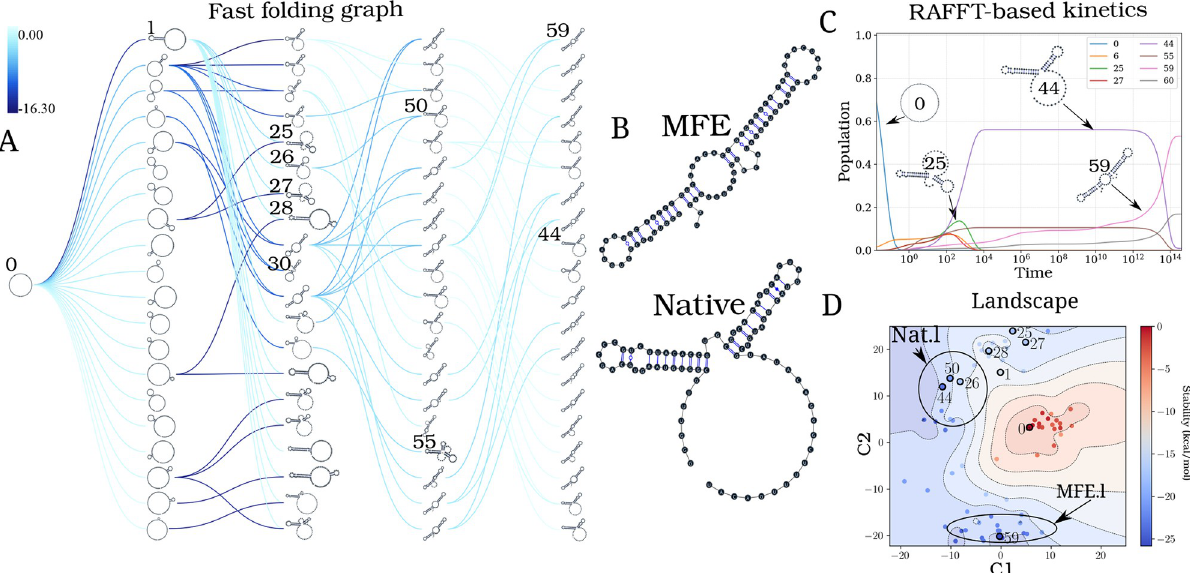
Fig 7. Application of the folding kinetic ansatz on CFSE. (A) Fast-folding graph in four steps and N = 20 structures stored in a stack at each step. The edges are coloured according to ΔΔ G . At each step, the structures are ordered by their free energy from top to bottom. The minimum free energy structure found is at the top left of the graph. A unique ID annotates visited structures in the kinetics. For example, “59” is the ID of the MFE structure. (B) MFE (computed with RNAfold ) and the native CFSE structure. (C)The change in structure frequencies over time. The simulation starts with the whole population in the open-chain or unfolded structure (ID 0). The native structure ( Nat.l ) is trapped for a long time before the MFE structure ( MFE.l ) takes over the population. (D) Folding landscape derived from the 68 distinct structures predicted using RAFFT . The axes are the components optimized by the MDS algorithm, so the base pair distances are mostly preserved. Observed structures are also annotated using the unique ID. MFE-like structures ( MFE.l ) are at the bottom of the figure, while native-like ( Nat.l ) are at the